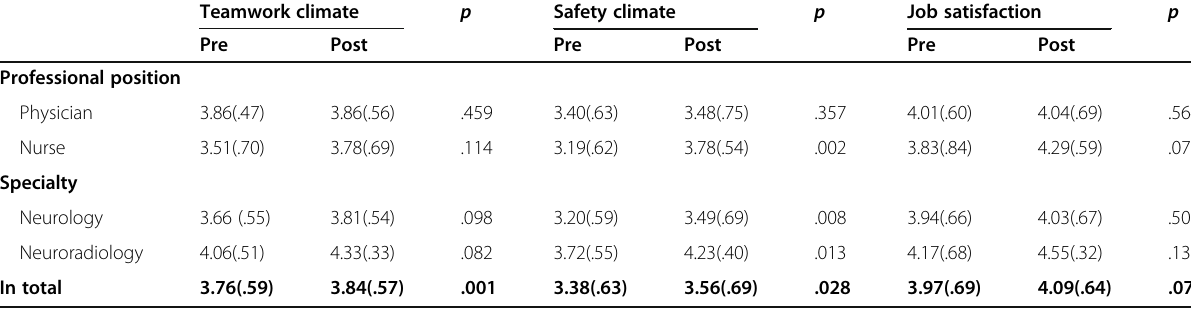
Table 3 Perceptions of patient safety climate per specialty, professional position and working experience Teamwork climate